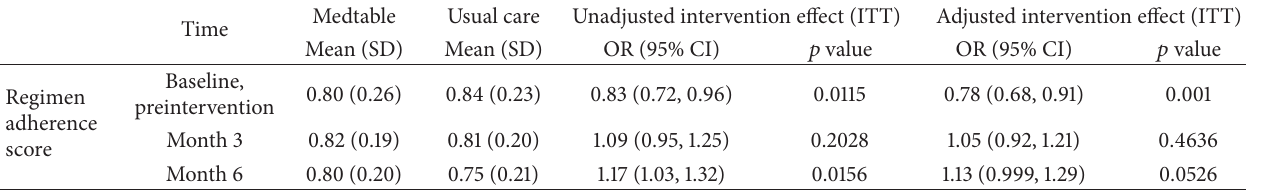
Table 6: Patients-reported adherence to their medication regimen before and after intervention: Medtable versus usual care.